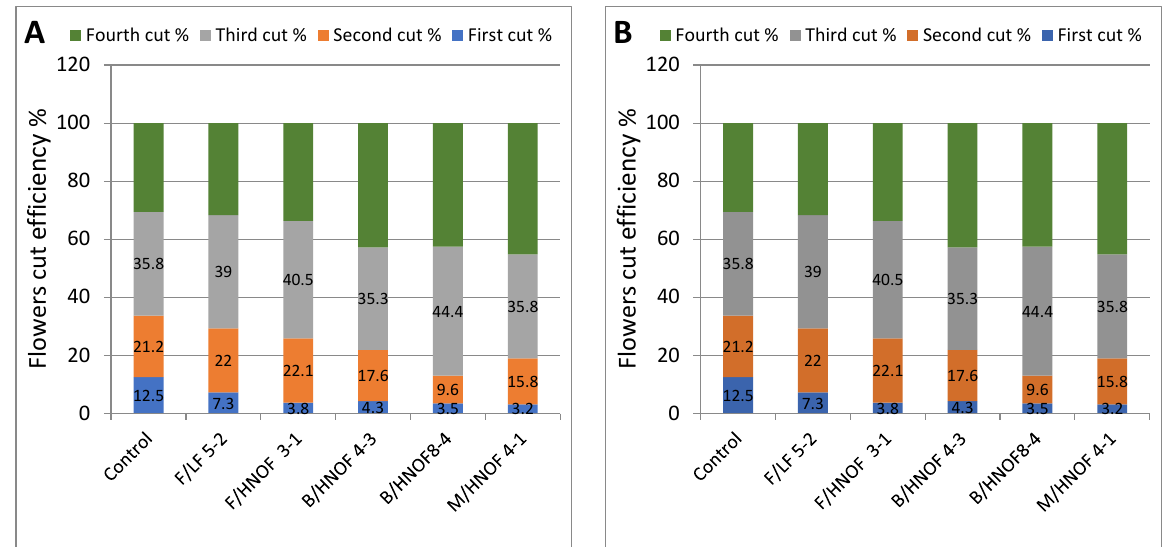
Figure 2 .Flower cut efficiency percentage of selected promising mutants. A . Flower cut efficiency Figure 2. Flower cut efficiency percentage of selected promising mutants. ( A ). Flower cut efficiency (%) in M 3 generation. B . Flower cut efficiency (%) in M4 generation. (%) in M 3 generation. ( B ). Flower cut efficiency (%) in M4